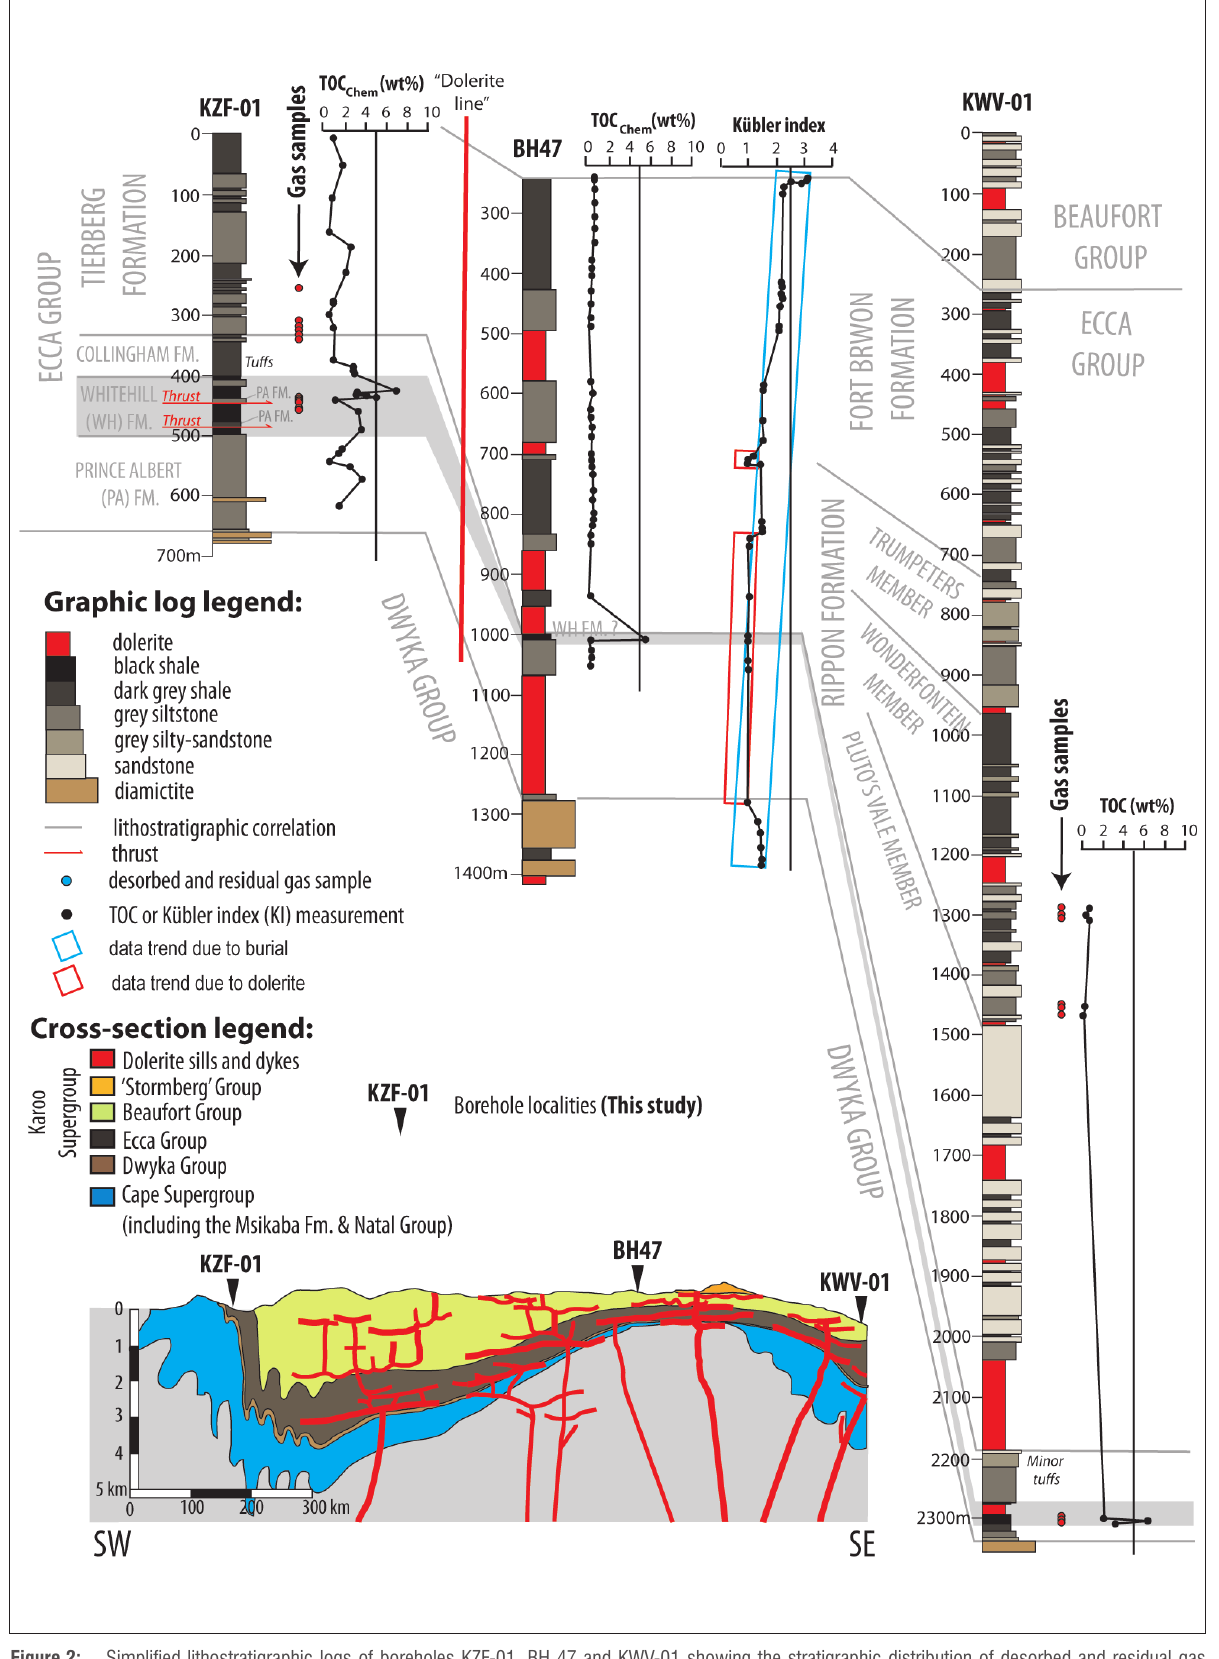
Figure 2: Simplified lithostratigraphic logs of boreholes KZF-01, BH 47 and KWV-01 showing the stratigraphic distribution of desorbed and residual gas samples, total organic carbon (TOC ) content, and Kübler index values. Also shown is a schematic cross section (SW–SE) of the southern Chem Karoo basin between the three cores